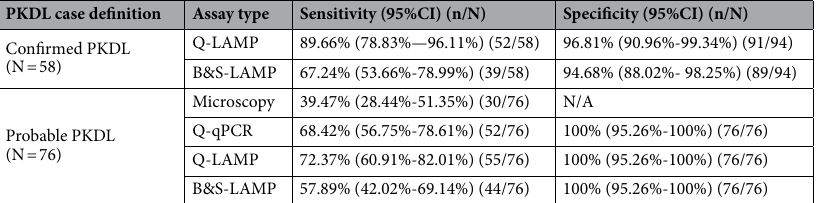
Table 2. Determining diagnostic efficiency of microscopy, qPCR and LAMP based on the PKDL case definition.